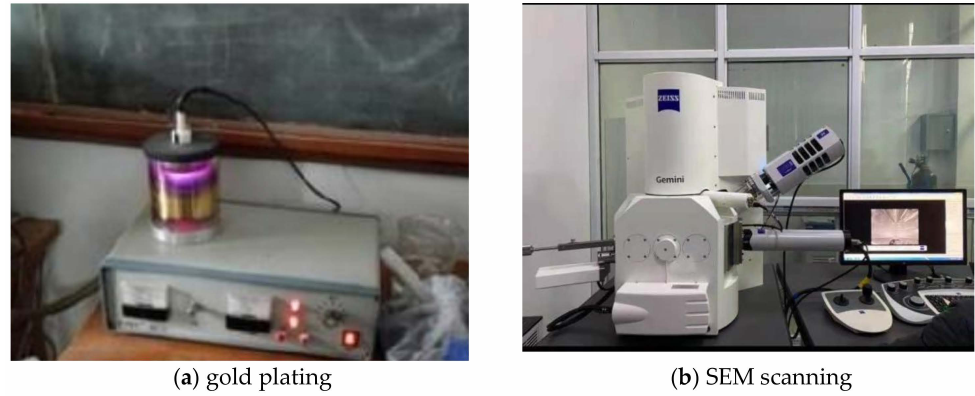
Figure 5. SEM scanning